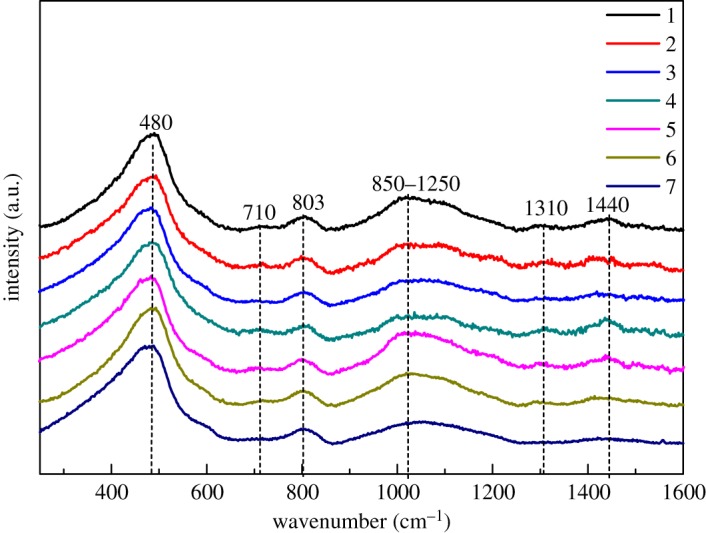
Raman spectra of TFT-LCD substrate glass.